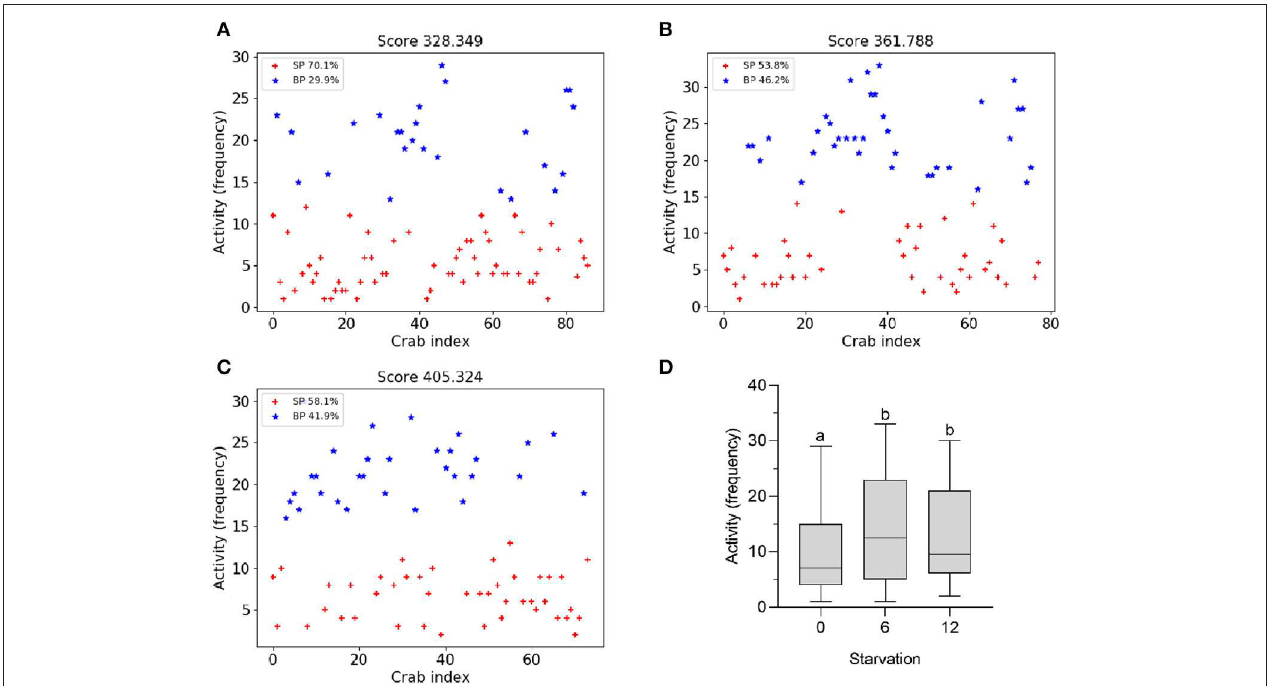
FIGURE 2 | Clustering result based on activity. (A–C) Represent the clustering results after 0, 6, and 12 days of starvation, respectively. The score is the SSE value of each clustering result. (D) Shows the changes in activity under different starvation conditions. In the clustering graph based on three factors, since the data is normalized, the values of all the influencing factors are scaled to 0–1. BP represents brave individual and SP represents shy individual. The following is the same.